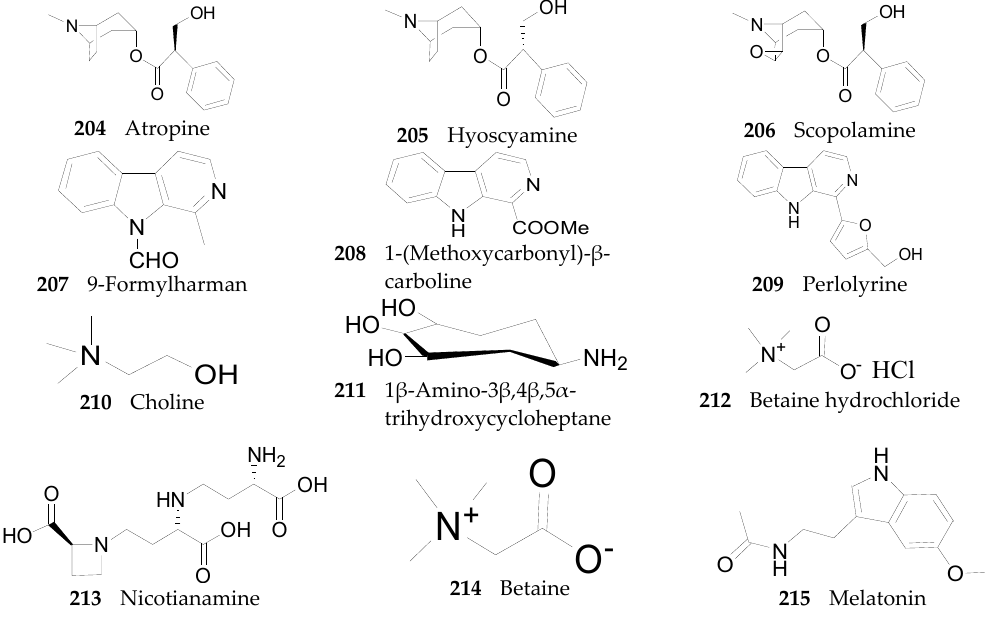
Figure 16. Chemical structures of compounds 204 – 215 .